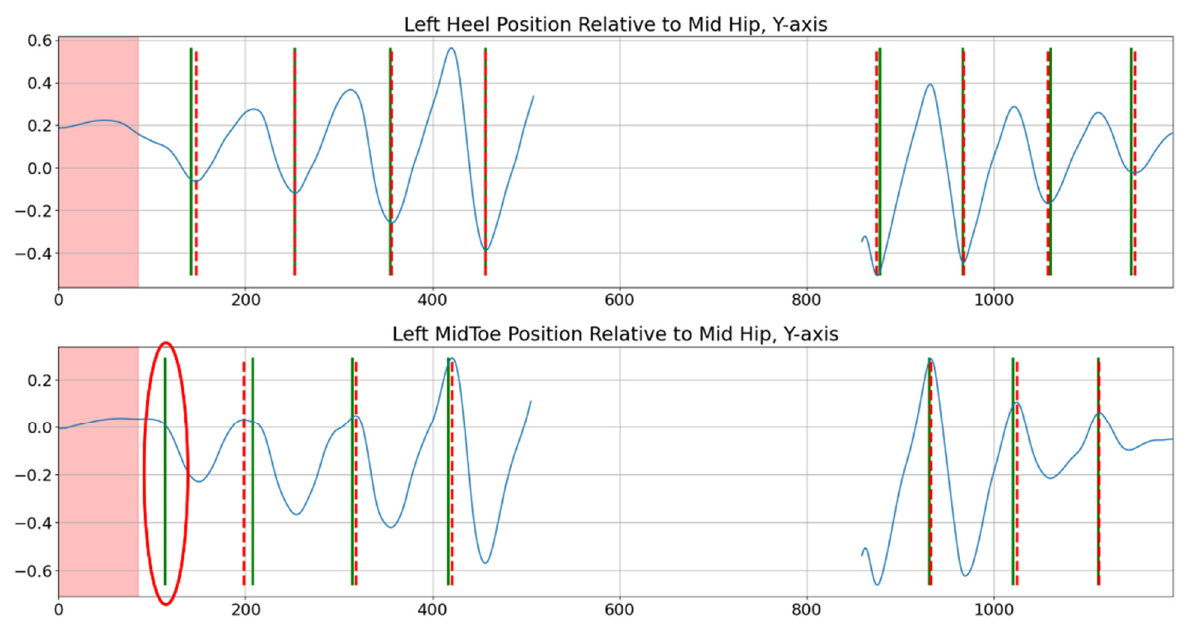
Figure 5. Foot-event detection. Solid green lines are ground-truth foot events, and dashed red lines are detected foot events. The solid green line circled in red shows an event that was missed but subsequently recovered using the IT recovery algorithm.